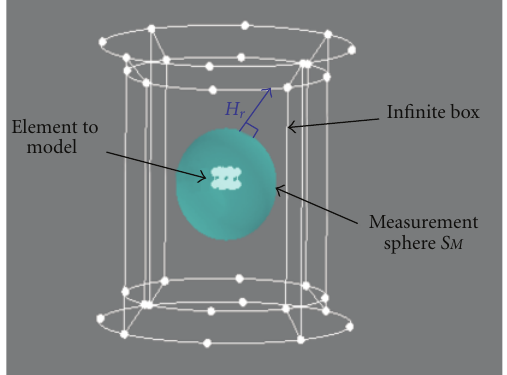
Figure 2: Source modeling Flux2D.